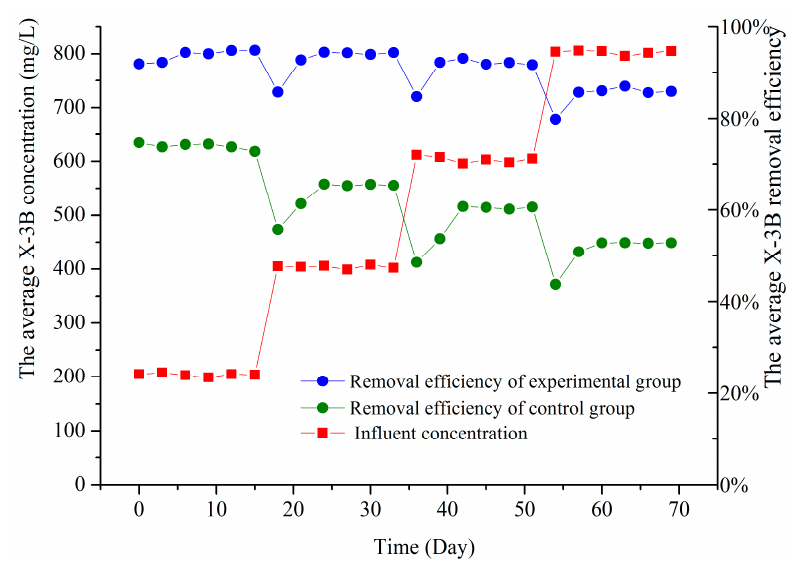
Figure 2. The average X-3B concentration and removal efficiency at different influent concentrations.